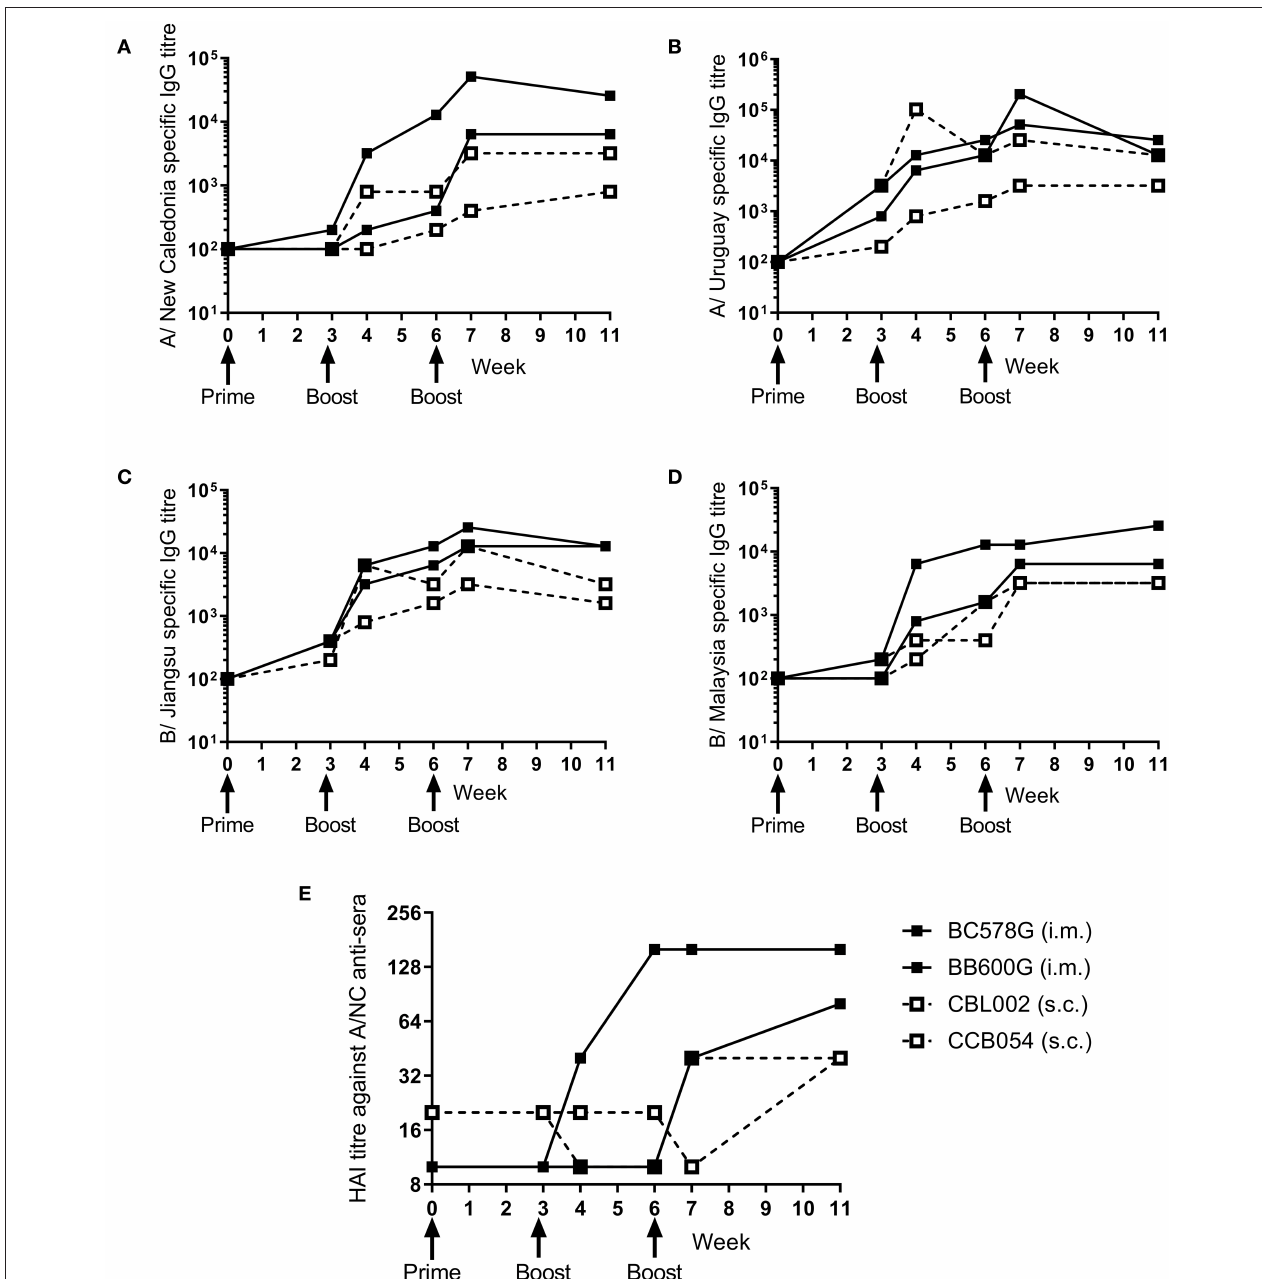
FIGURE 3 | Ciliate produced rHA induces an antibody response in NHP. NHP were immunized three times at 3 weekly intervals with 45 µ g each of A/NC (A) , A/Uru (B) , B/Jia (C) , and B/Mal (D) by the intramuscular (i.m.) or subcutaneous (s.c.) routes, n = 2 animals per route. Blood samples for ELISA (A–D) and haemagglutination inhibition (E) analysis were